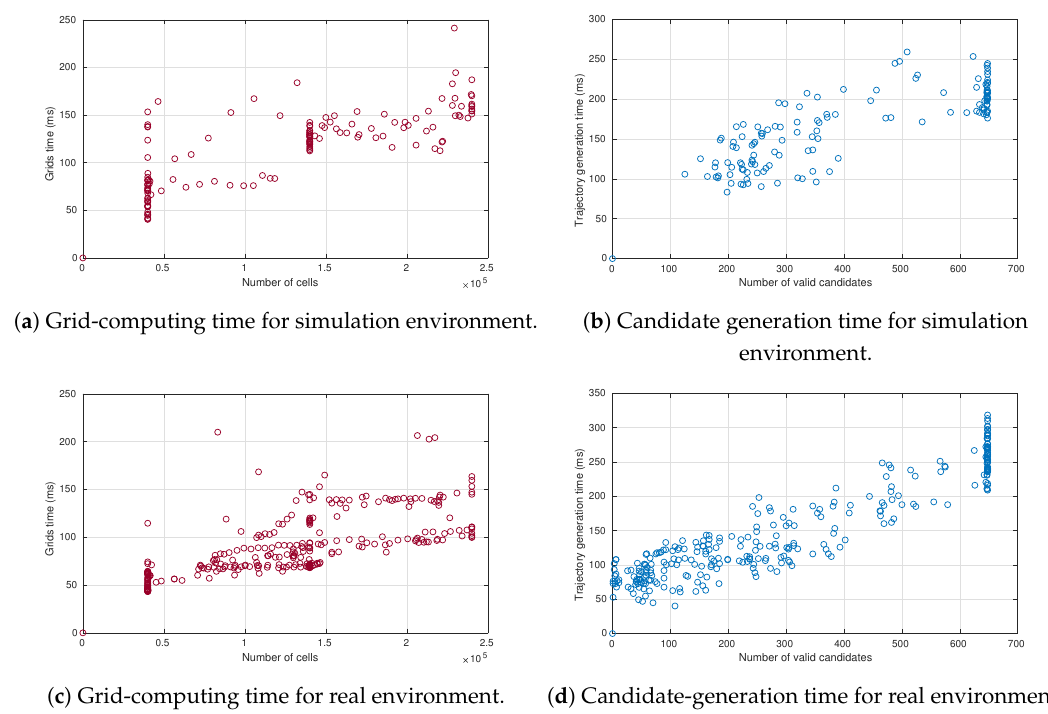
( d ) Candidate-generation time for real environment. Figure 26. Times for grid and candidate